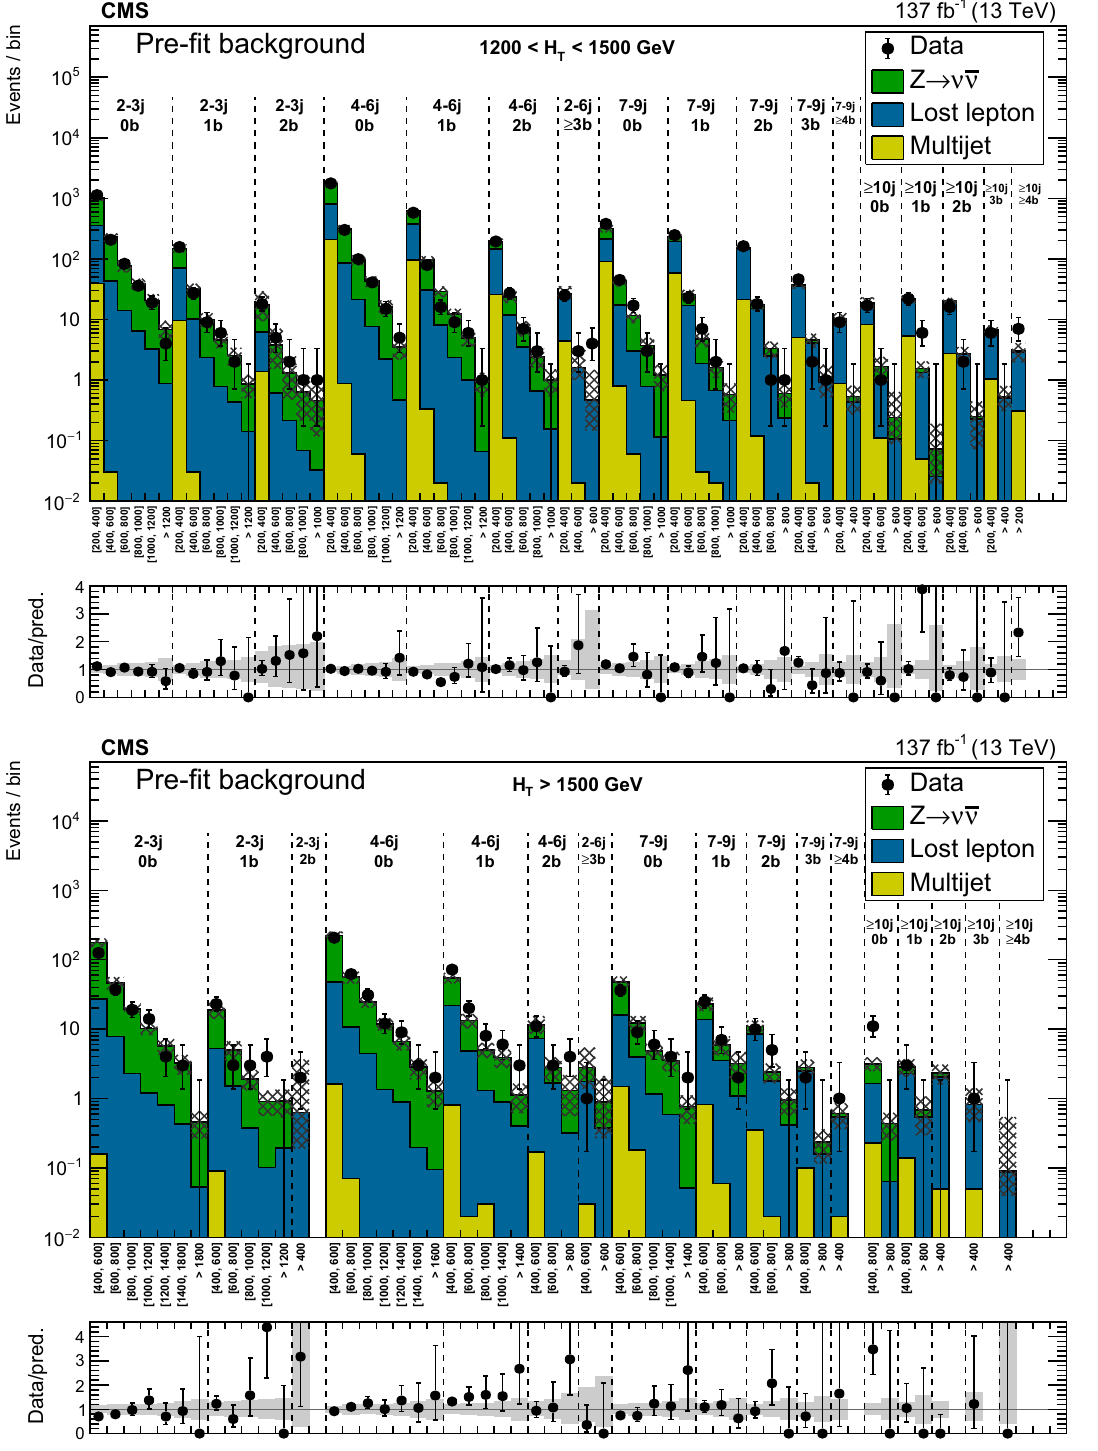
Fig. 24 (Upper) Comparison of the estimated background and observed data events in each signal bin in the high- H T region. The hatched bands represent the full uncertainty in the background esti-